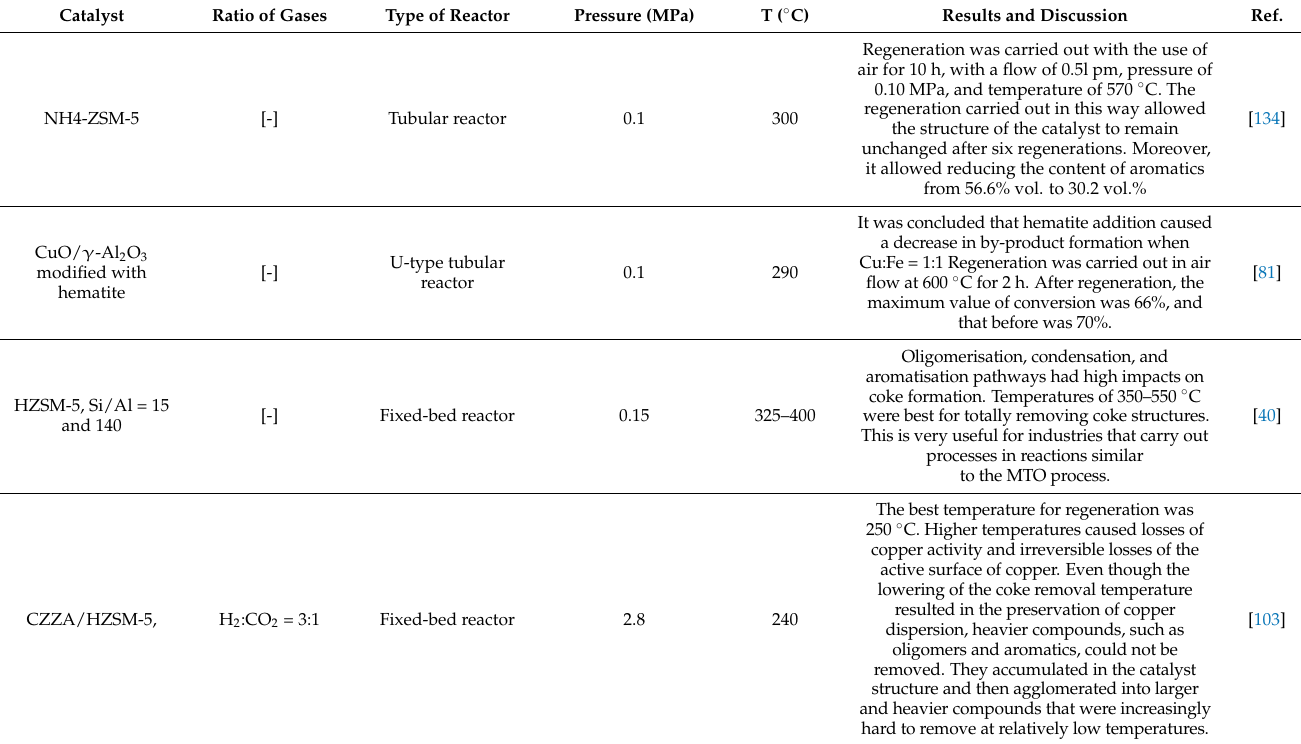
Table 3. Regeneration strategies of DME